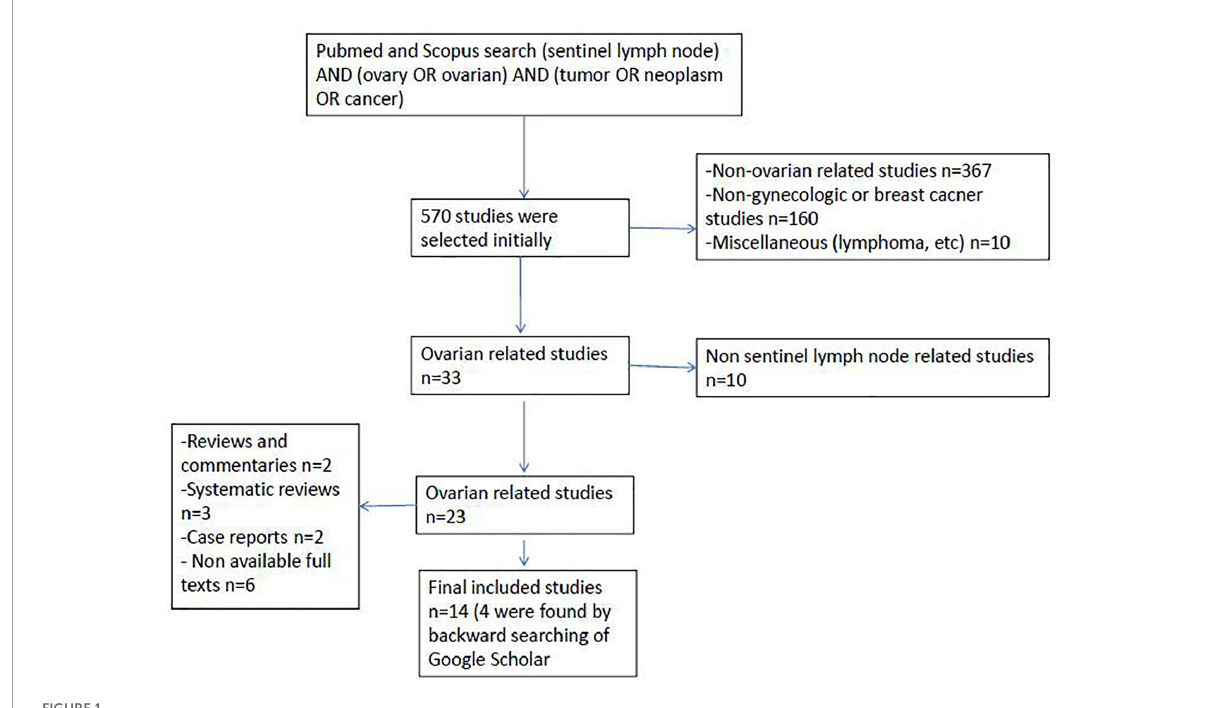
FIGURE1 Flow chart of the study